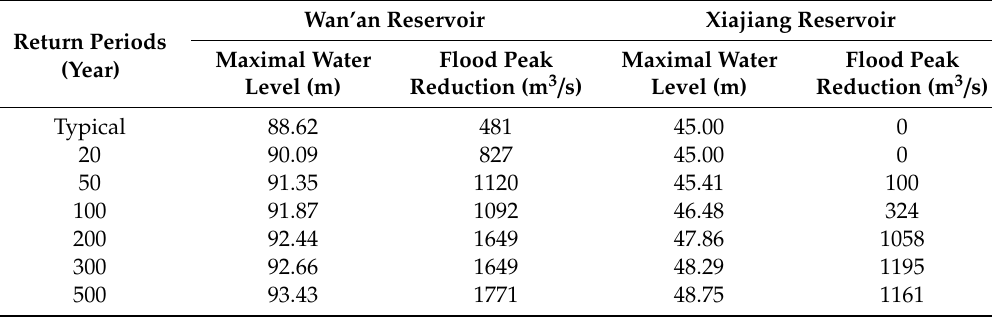
Table 6. Results of Wan’an–Xiajiang cascade reservoirs using DP-POA.